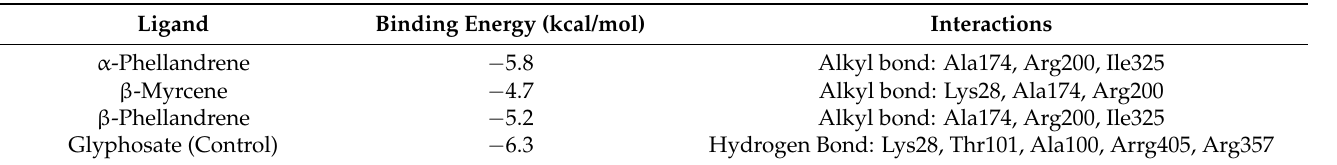
Table 4. Molecular docking of the major volatile components of P. acutifolium and glyphosate